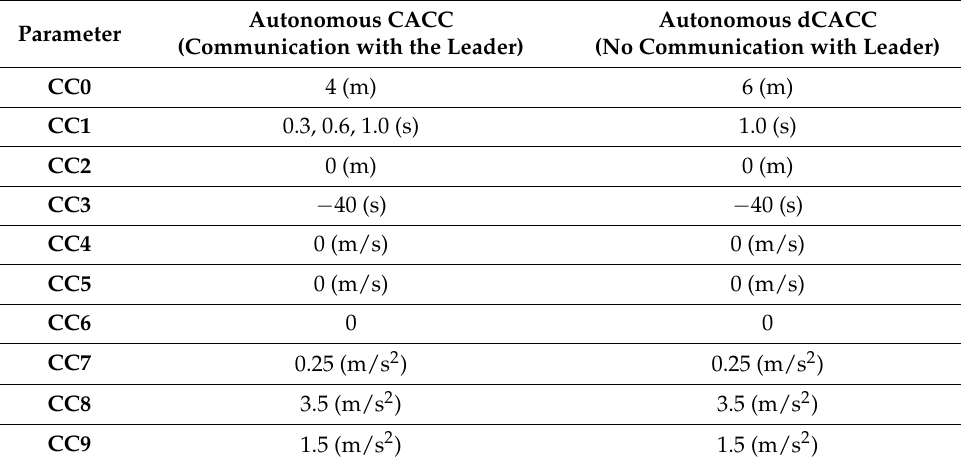
Table 7. Parameters for AV simulation using Wiedmann 99 model [57]. Parameter